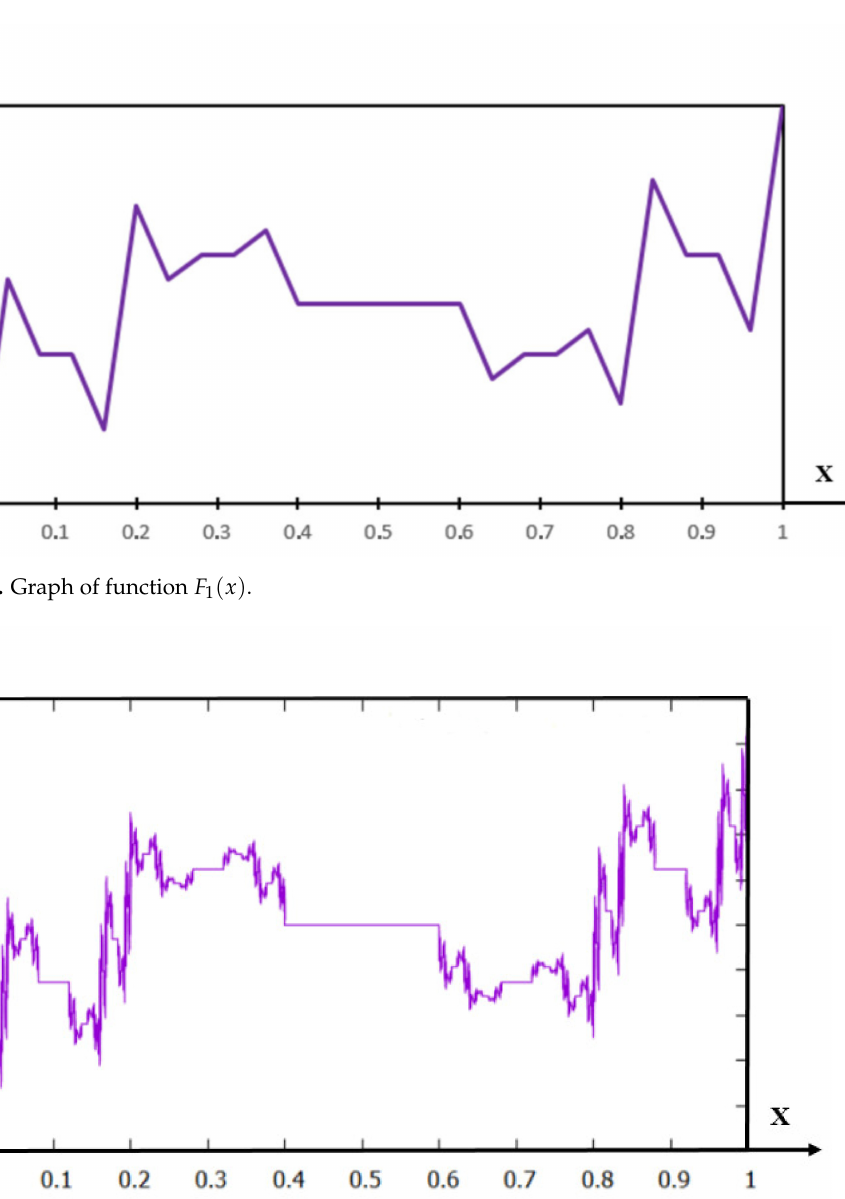
Figure 10. Graph of function F 15 ( x )